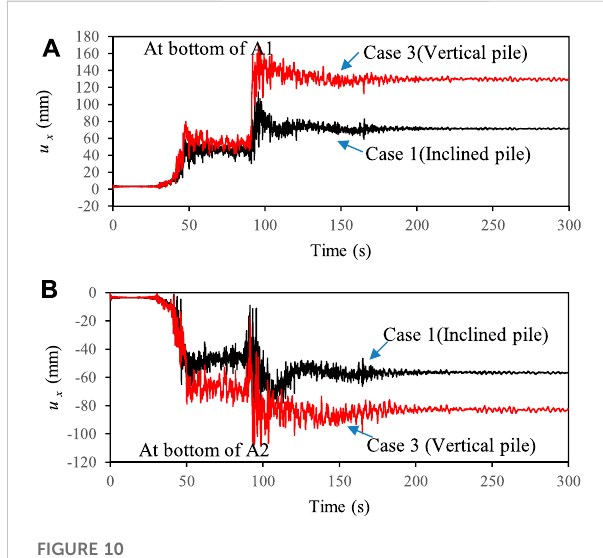
FIGURE 10 Effect of the pile rake angle on the lateral displacement at the bottom of (A) A1 and (B) A2 abutments.